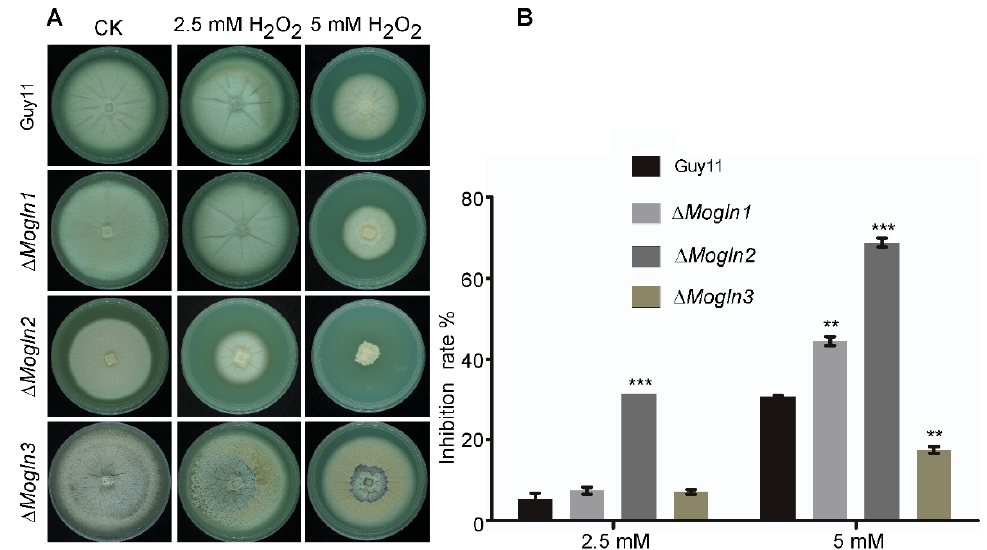
Figure 11. Sensitivity of the three MoGLN mutants to H 2 O 2 . ( A ) Growth phenotype of the WT and MoGLN mutants under oxidative stress. The WT and three mutant strains were inoculated on CM agar medium with or without 2.5 mM H 2 O 2 and 5 mM H 2 O 2 and cultured at 28 °C for 10 days. ( B ) The colony diameters of the strain tested were measured, and statistical analysis was performed. The growth inhibition rate was compared to the growth rate of each untreated control (Inhibition rate = (the diameter of untreated strain − the diameter of treated strain)/(the diameter of untreated strain × 100%)). Three independent repeats were performed, with similar results obtained. Error bars denote the standard deviations from means obtained from three independent replicates. Asterisks indicate statistically significant differences (**, p < 0.01; ***, p < 0.001; one-way ANOVA was used to analyze data with Turkey’s multiple-comparison test in Graph Pad Prism 8).